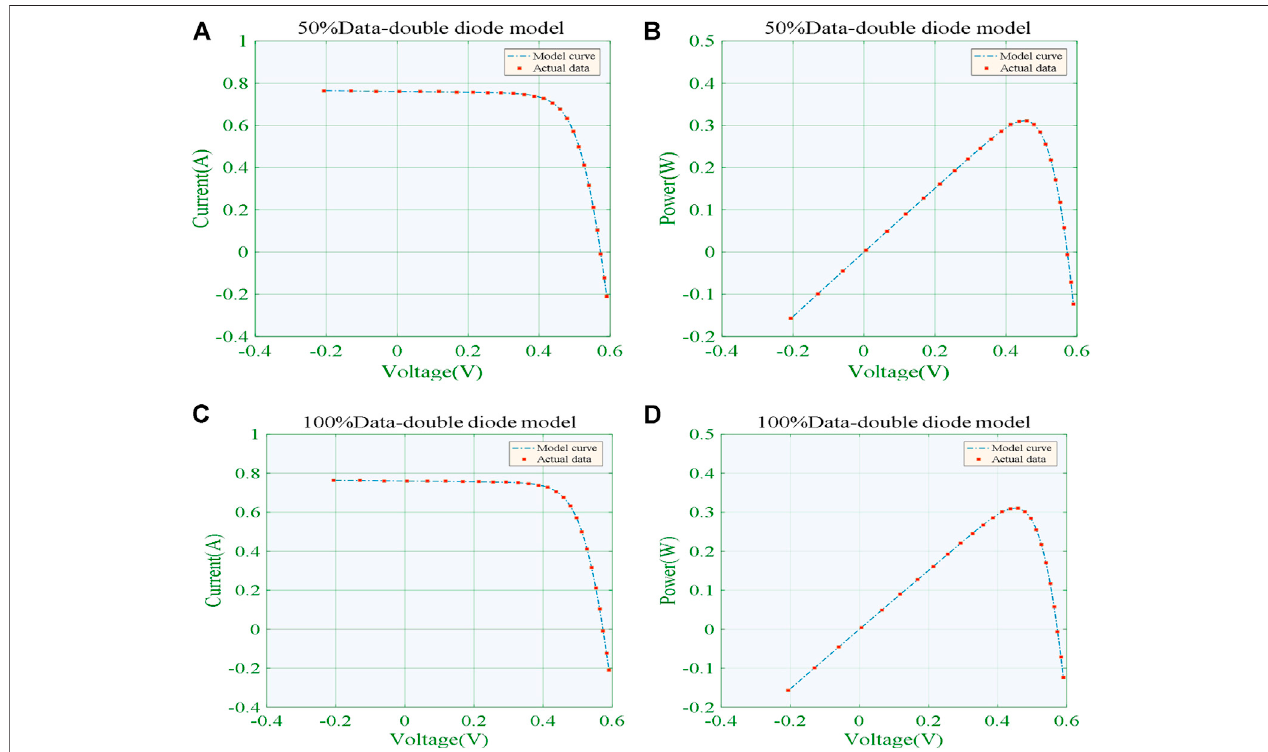
FIGURE 12 | Radars of average RMSE achieved by different algorithms for the SDM.